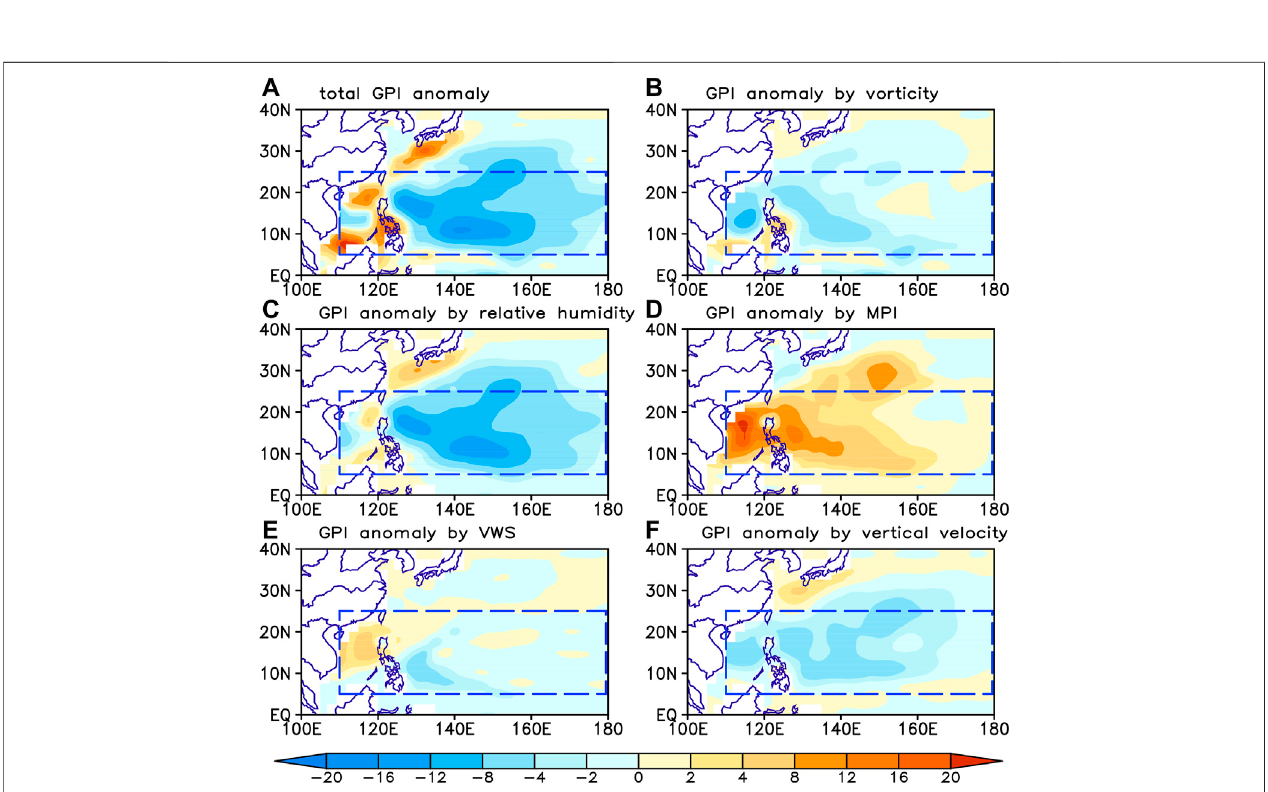
FIGURE 2 | (A) Total GPI anomaly in July 2020 and the respective contribution from the individual variables for (B) 850-hPa absolute vorticity, (C) 600-hPa relative humidity, (D) maximum potential intensity, (E) VWS, and (F) 500-hPa vertical pressure velocity. The blue dashed box (5 ° -25 ° N, 110 ° E-180 ° ) represents the main TC genesis region over